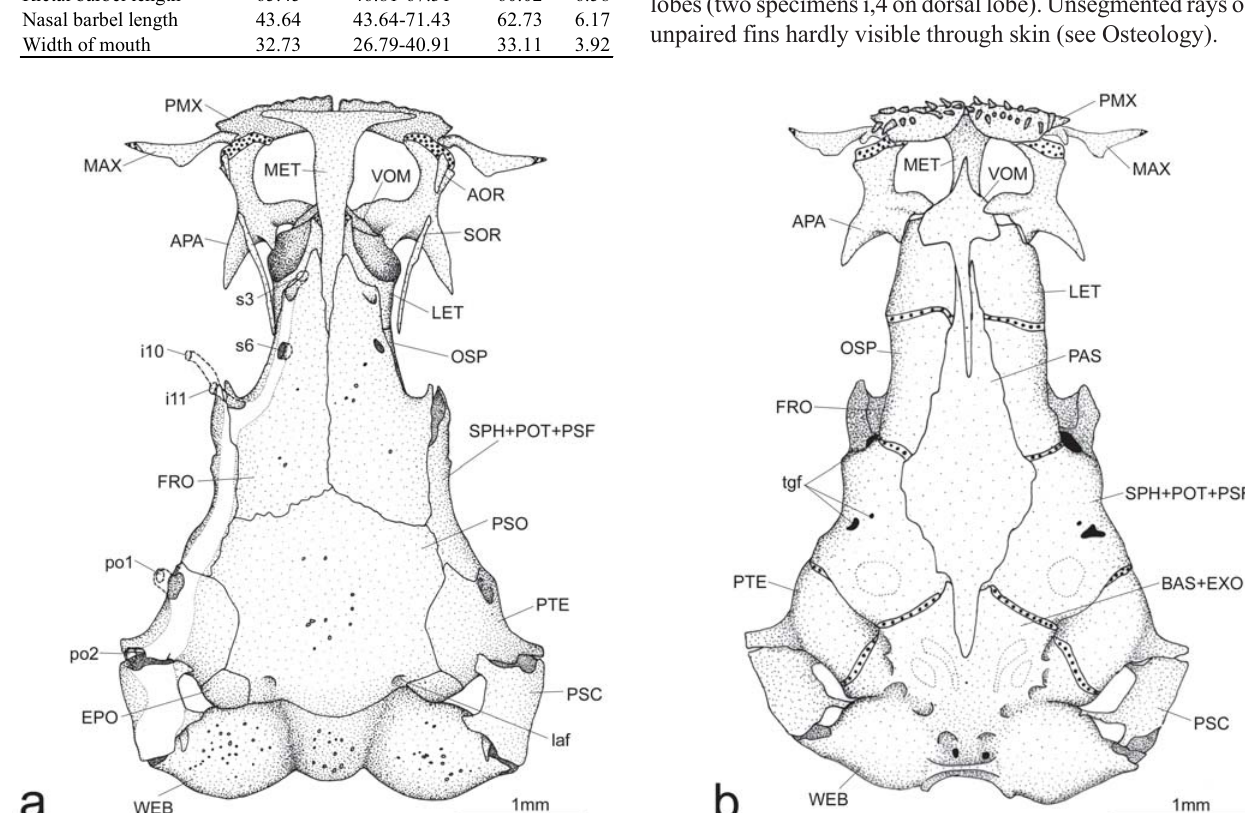
Fig. 2. Skull and Weberian apparatus of Ituglanis macunaima . a, paratype, LIRP 5642, 29.1 mm SL, dorsal view; b, paratype, MZUSP 86251 (25.5 mm SL), ventral view. Abbreviations: AOR, antorbital; APA, autopalatine; BAO+EXO, basioccipital- exoccipital bone; EPO, epioccipital; FRO, frontal; i10-11, infraorbital sensory pores 10 to 11; laf, ramus lateralis acessorius facialis foramen; LET, lateral ethmoid; MAX, maxilla; MET, mesethmoid; OSP, orbitosphenoid; PAS, parasphenoid; PMX, premaxilla; po1-2, postotic sensory pores 1 to 2; PSC, “posttemporosupracleithrum”; PSO, parieto-supraoccipital; PTE,